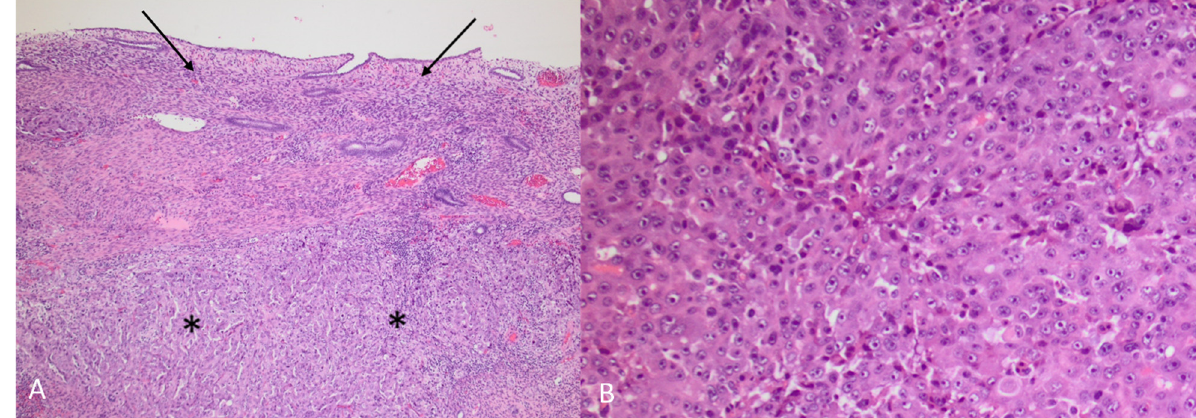
Figure 9. ( A ) HAC (asterisks) growing under intact endometrium (arrows) (Hematoxylin and eosin, 5 × ) ( B ) HAC (Hematoxylin and eosin, 10 × ). The tumour was a poorly differentiated adenocarcinoma, primarily growing in solid sheets under a non-neoplastic endometrium. The morphology was not characteristic, and a vague trabecular pattern could only be recognized focally. The tumour cells were polygonal with enlarged, round nuclei and prominent nucleoli and with an abundant cytoplasm. There were numerous mitoses and apoptosis. Prominent blood vessel invasion was pre-